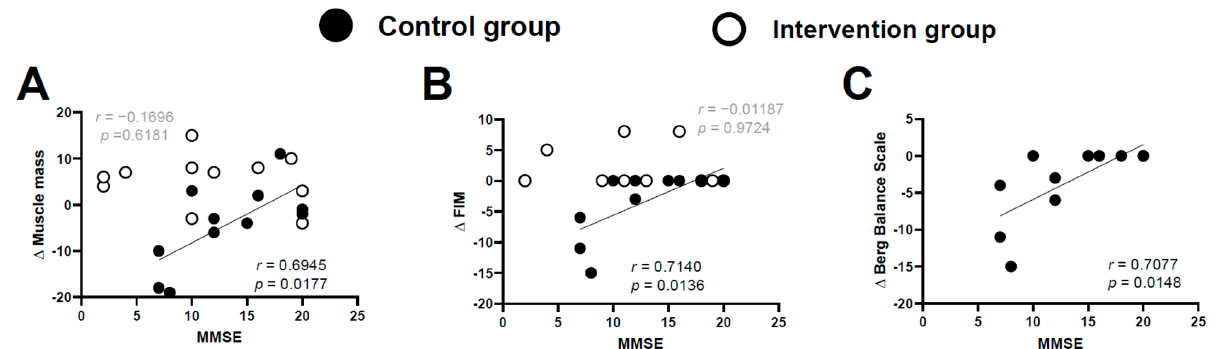
Figure 3. Correlations between the MMSE score and Δ muscle mass ( A ), Δ FIM ( B ), and Δ BBS score ( C ). Strong correlations were observed between the MMSE score and Δ muscle mass, Δ FIM score, and Δ BBS score in the control group (Bonferroni correction; critical alpha <0.05/2 = 0.025). Data from the intervention group are not shown in Figure C because none of the individuals in this group had a decreased BBS score.